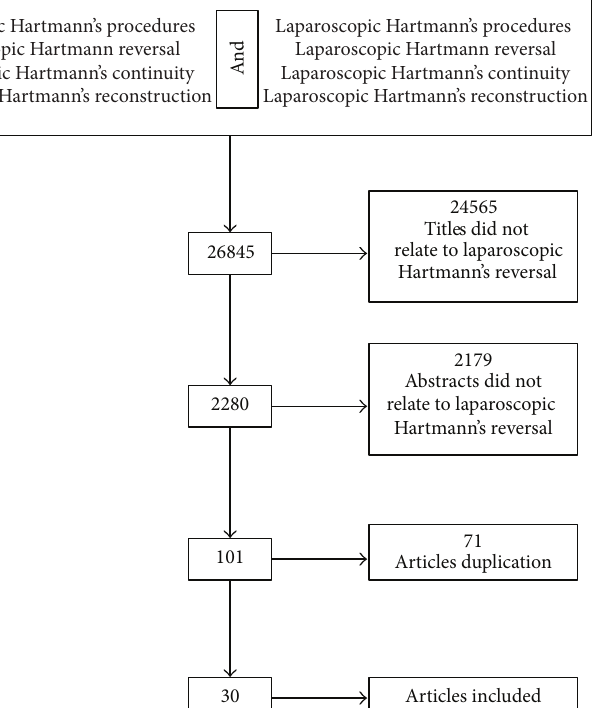
Figure 1: Flowchart describing the selection of studies included in this